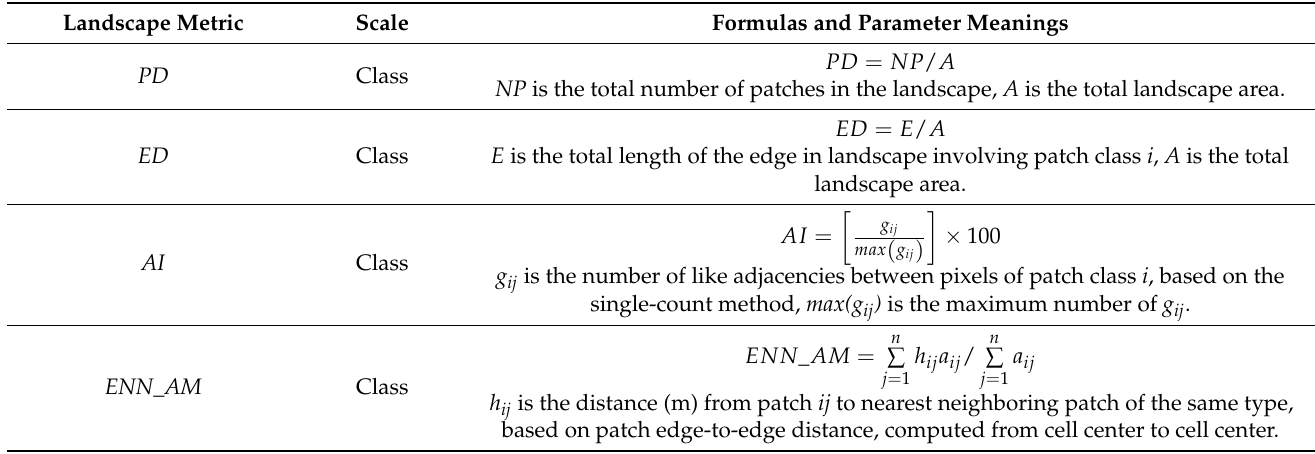
Table 1. Explanation of landscape